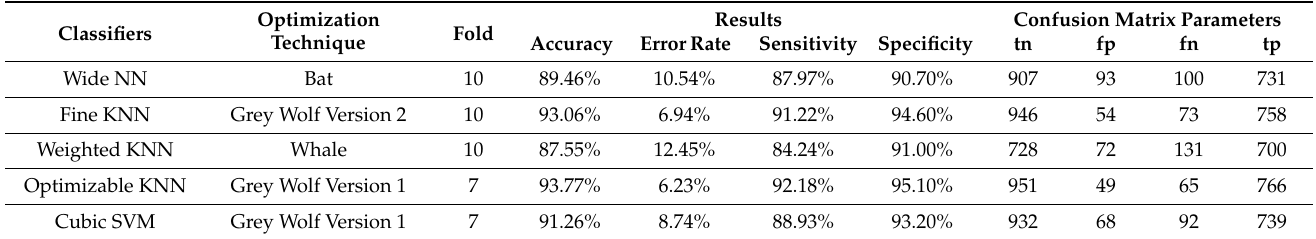
Table 6. Performance of various classifiers using GLRLM, statistical features, and Hu’s invariant moments.